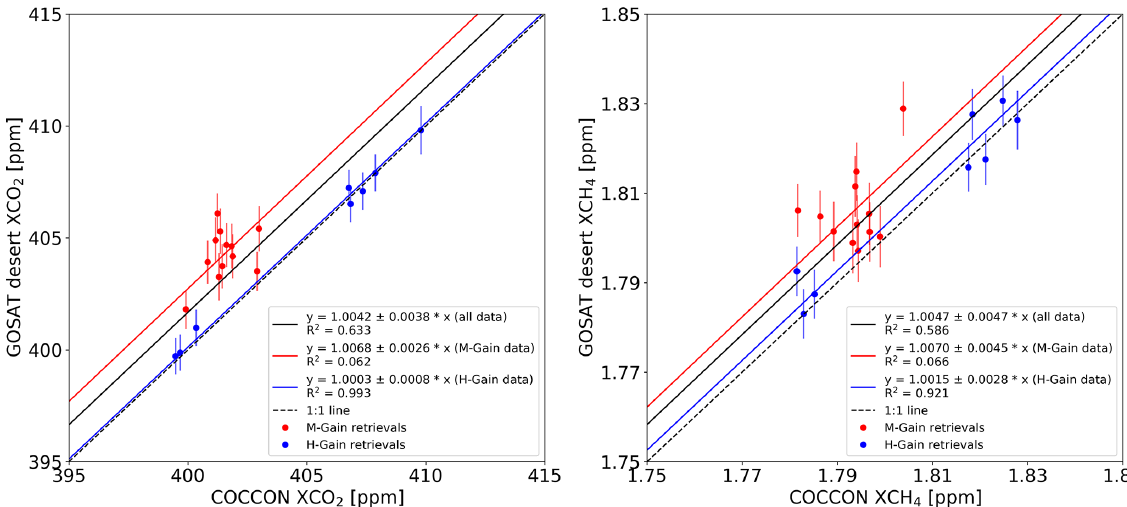
Figure 13. Same as Fig. 12, with GOSAT observations over the sand desert.